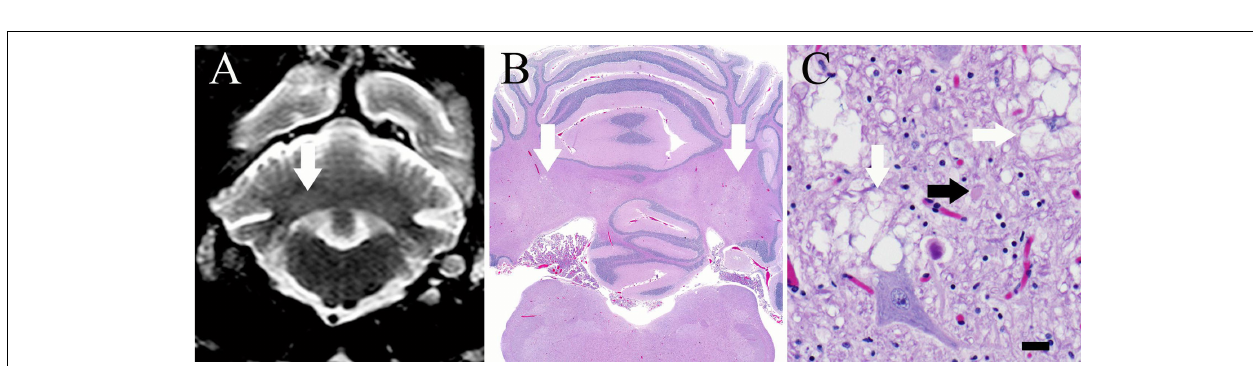
FIGURE 2 | (A) Transverse T2-weighed turbo spin echo MR image at the level of the cerebellar nuclei. There are subtle, bilaterally symmetric hyperintensities of the cerebellar nuclei (white arrow) that correspond to areas of vacuolation on histopathology. (B) Brain, dog. Subgross photomicrograph of the cerebellum and medulla. Multifocal regions of pallor are present at the level of the lateral, interposital, and fastigial nuclei (white arrows), corresponding with the MRI. H&E stain. (C) Brain, dog. High magnification photomicrograph of the cerebellum within a pale region denoted by the arrows in (B) . Note the myelin vacuolation (white arrows) and axonal swelling (spheroid, black arrow). There are increased numbers of glial cells in this region, including microglia and astroglia, which are multifocally undergoing cytoplasmic swelling. H&E stain; 400 (cid:2) magnification; bar = 20 (cid:22) m.